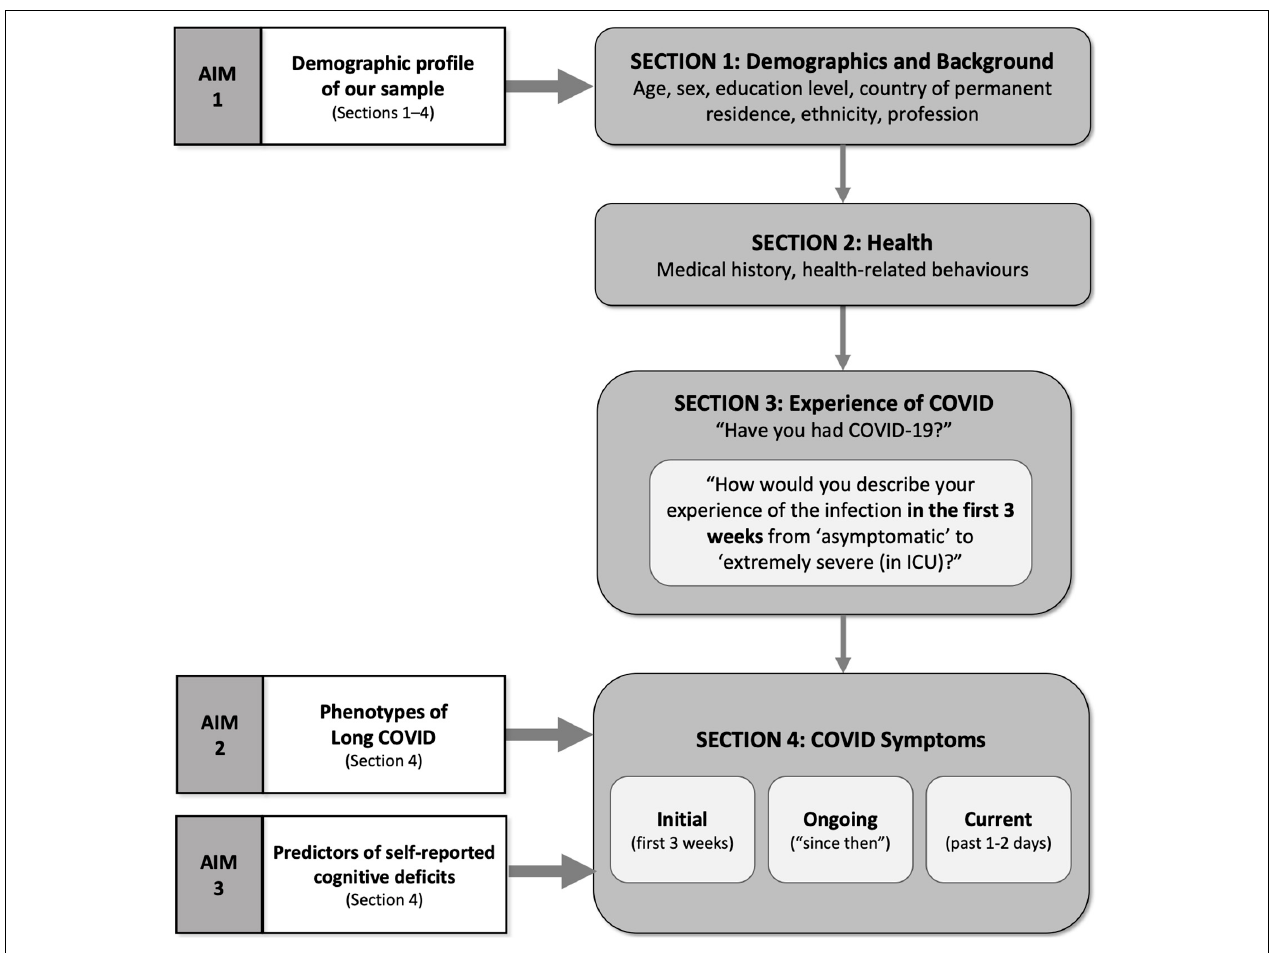
FIGURE 2 | Data analyzed in relation to our study